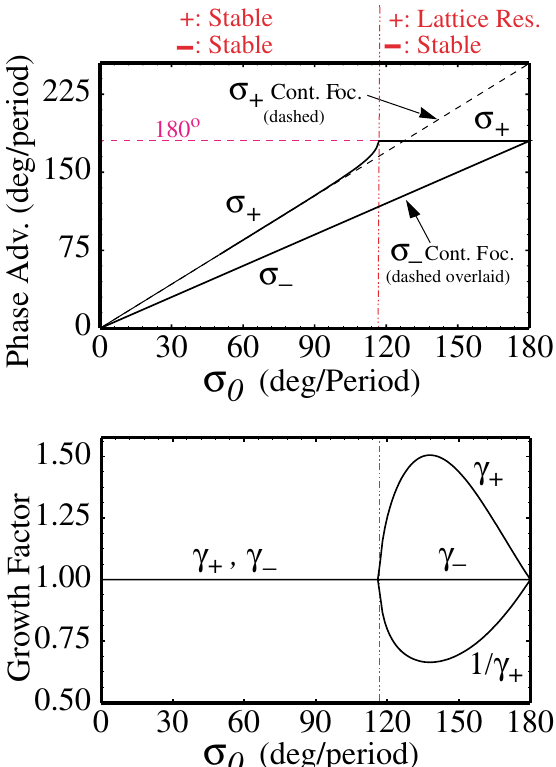
FIG. 26. (Color) Phase advance ( (cid:24) and (cid:24) ) and growth fac- Q B and (cid:6) ) for the breathing and quadrupole modes tors ( (cid:6) Q B for a thin-lens FODO quadrupole focusing channel versus (cid:24) for a thin- 0 0 and a fully depressed beam with (cid:24) (cid:1) 0 . Continuous focusing model predictions for (cid:24) (cid:16) are indicated with dashed lines.